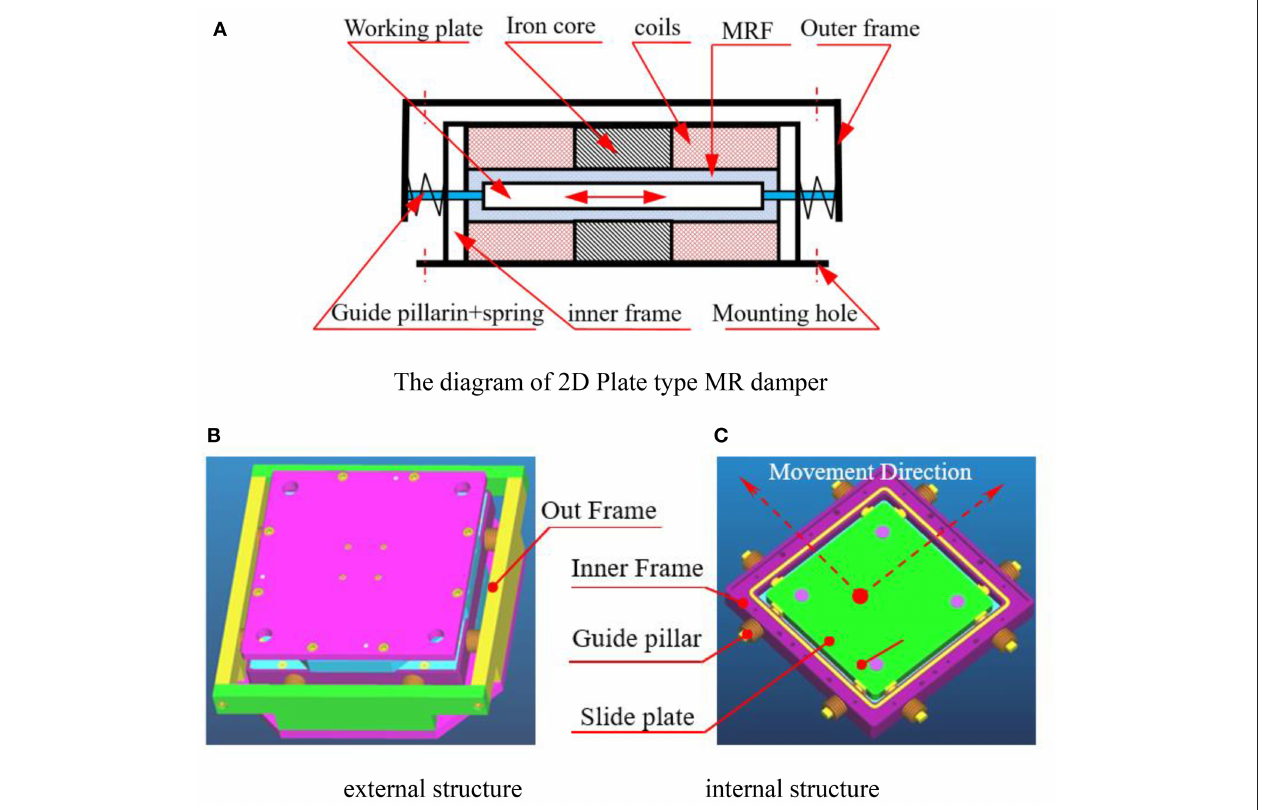
FIGURE 1 | Structure of bipolar coil 2-D plate-type MRD. (A) The diagram of 2D Plate type MR damper. (B) External structure. (C) Internal